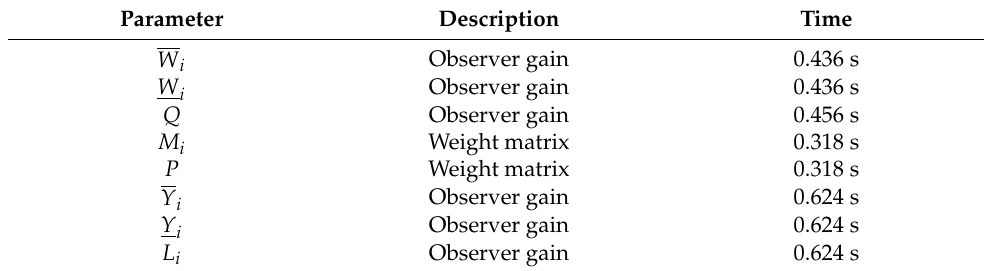
Table 2. Complexity of the calculation.